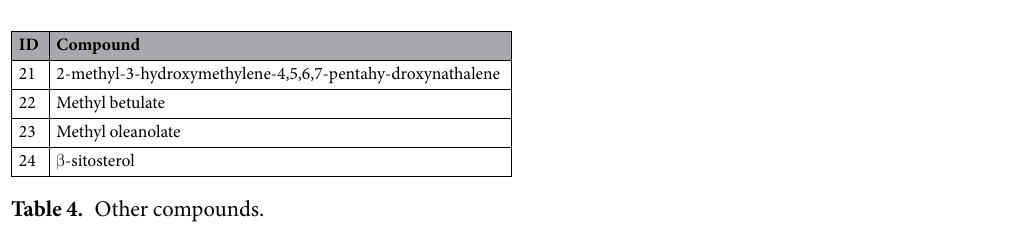
Figure 6. Distribution of Turkish galls target proteins on the compressed UC pathway. Induction of PPAR- γ expression in intestinal epithelial cells by lipopolysaccharide (LPS) activates TLR4, leading to regulation of NF- κ B control of the inflammatory response. COX-2, which is downstream of the NF- κ B pathway, shows a similar response to Turkish galls treatments. Also, there is a subsequent reduction in the expression of inflammatory factor IL-6 and TNF- α . Tregs play a crucial role in UC and they are capable of modulating effector T cells and antigen-presenting cells (APC) by secreting anti-inflammatory cytokines, such as IL-10.